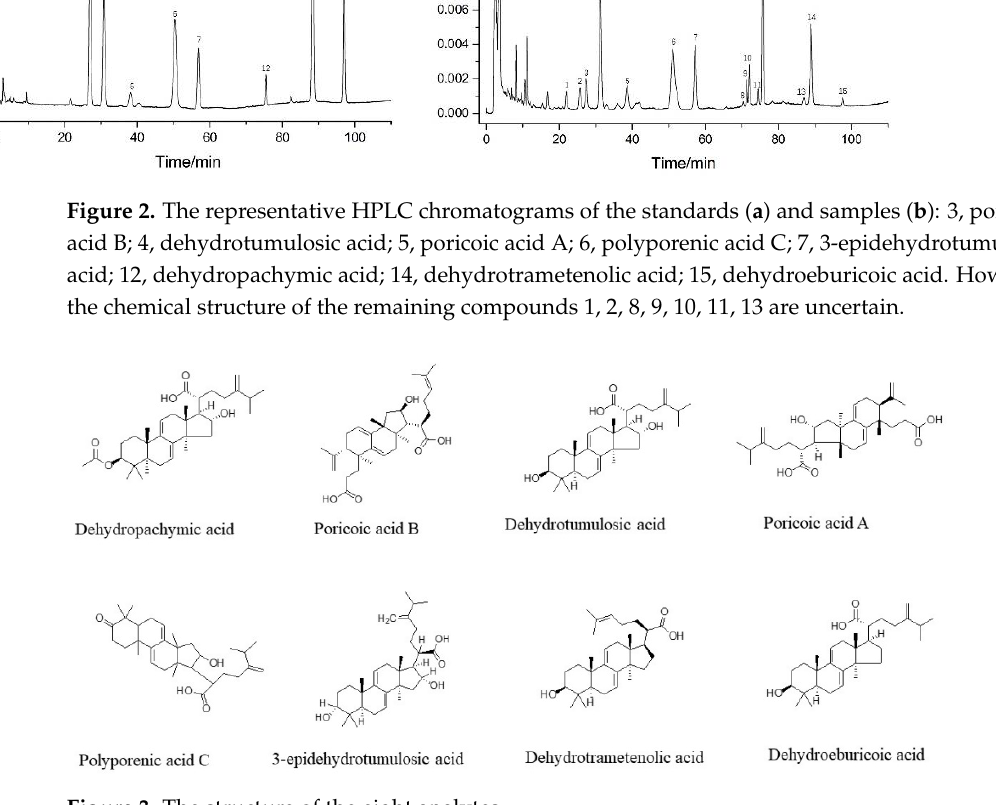
Figure 3. The structure of the eight analytes.